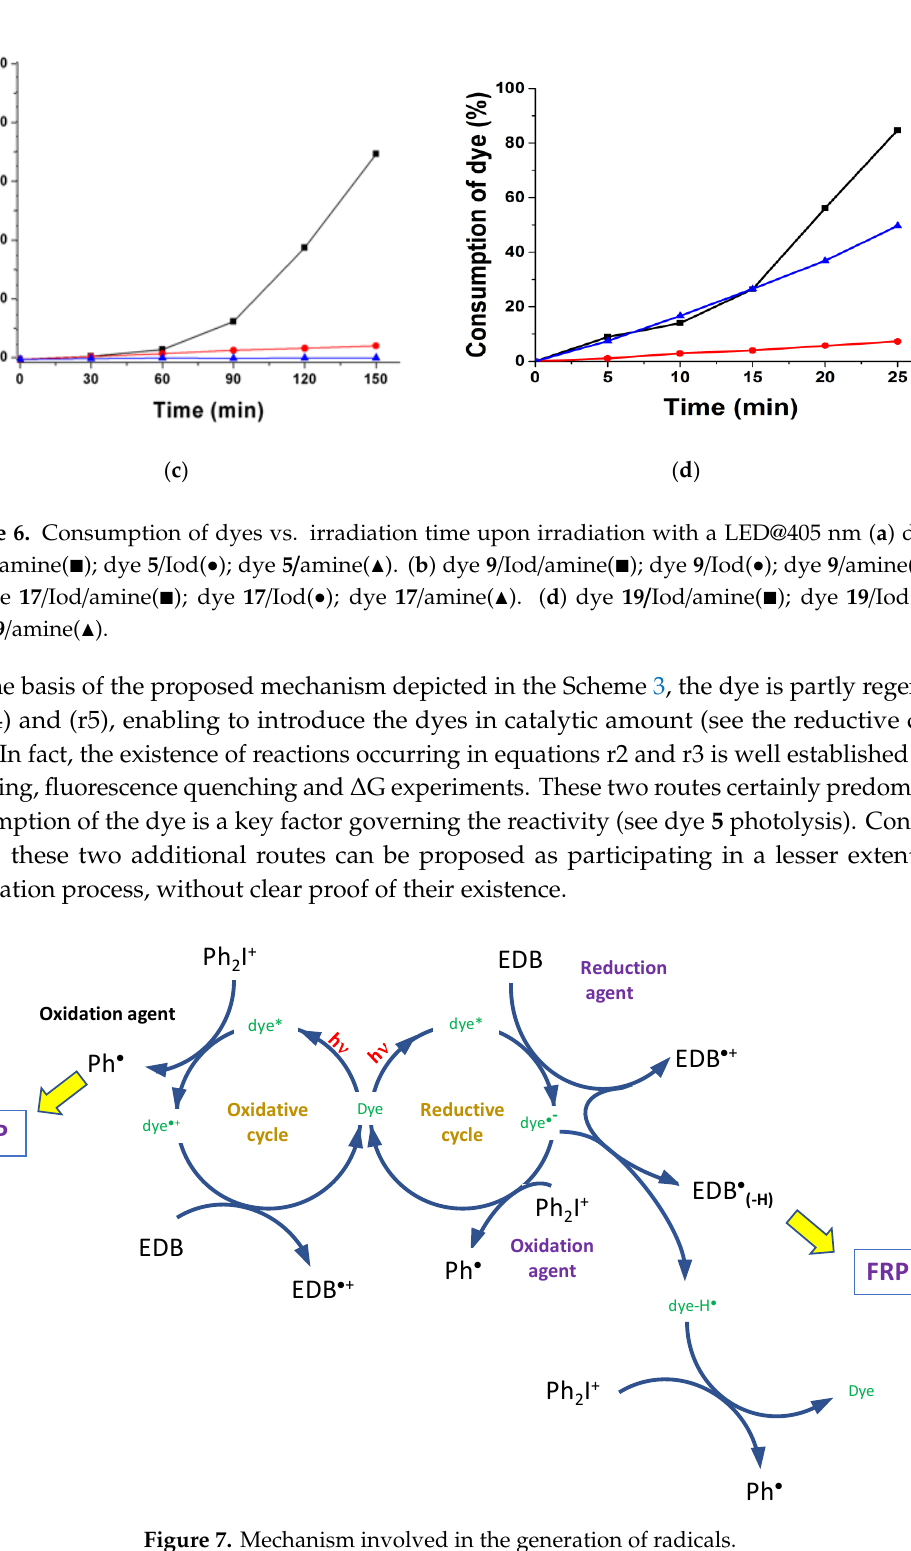
Figure 7. Mechanism involved in the generation of radicals.